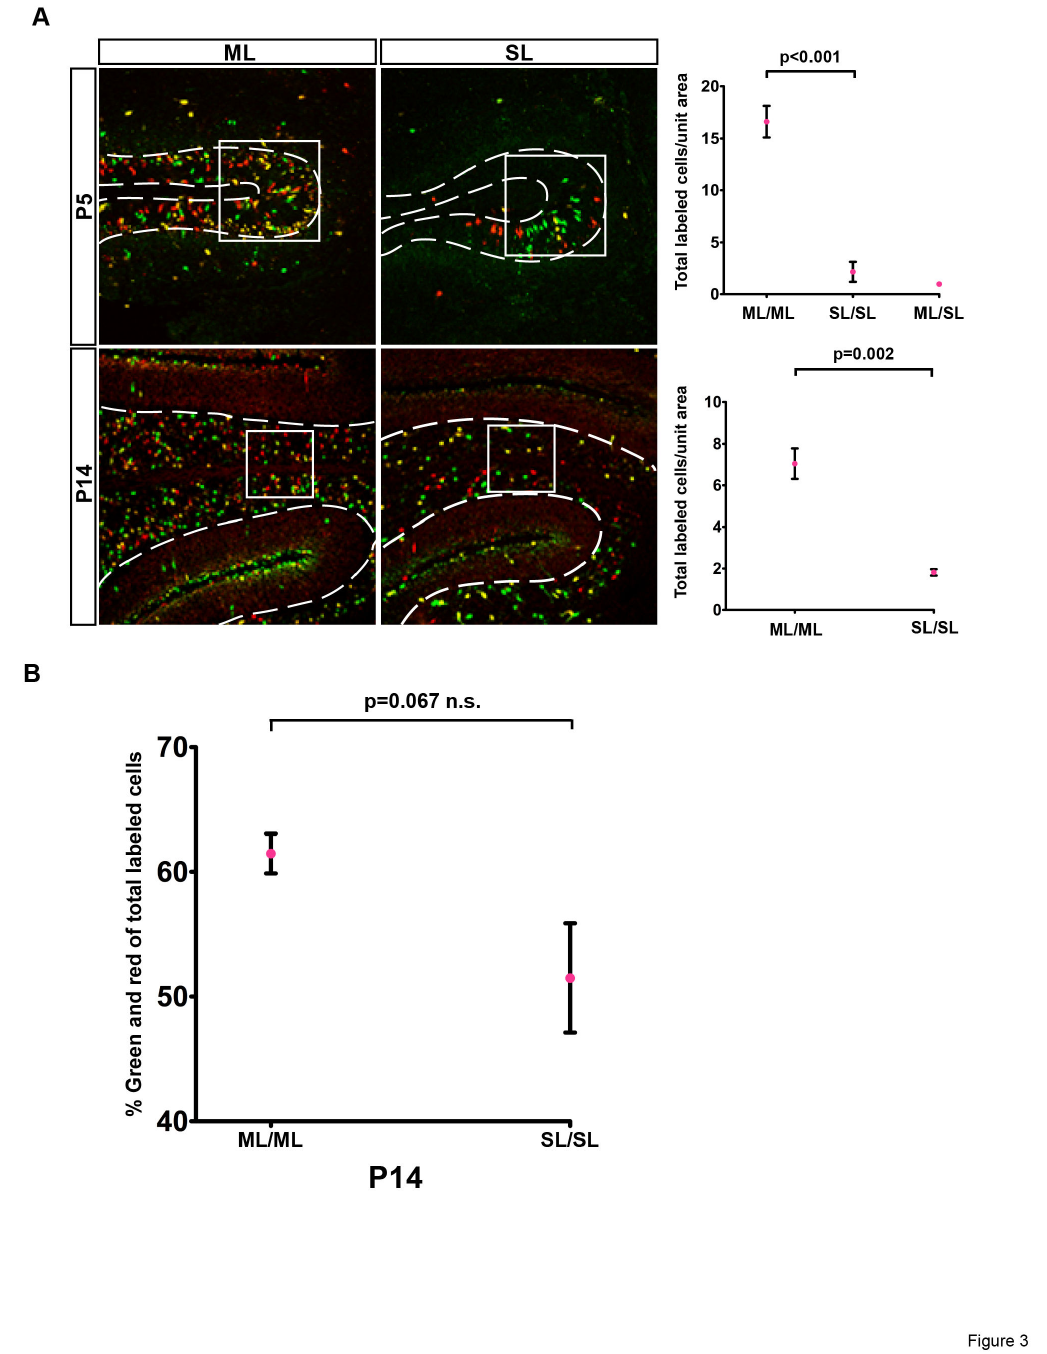
Figure 3. MADM-ML has significantly higher recombination efficiency than MADM-SL, and maintains the productive G2-X segregation pattern. (A) Representative images of cerebella in MADM Math1-Cre mice at P5 and P14 with quantification areas outlined (EGL for P5, IGL for P14). MADM-ML has significantly more labeled cells than MADM-SL does, for both P5 and P14 data set. P5 data (n=5 for ML/ML, n=4 for SL/SL, and n=5 ML/SL) are analyzed by ANOVA and multiple comparisons with Tukey HSD. There is no significant difference between SL/SL and ML/SL. P14 data (n=5 for ML/ML and n=7 for SL/SL) are analyzed by an independent samples t-test with unequal variance. (B) There is no significant difference in G2-X segregation frequency between the two MADM systems, as measured by percent of green and red cells among total labeled cells. n=5 for ML/ML and n=7 for SL/SL. Error bars are one standard deviation. doi: 10.1371/journal.pone.0077672.g003 PLOS ONE |